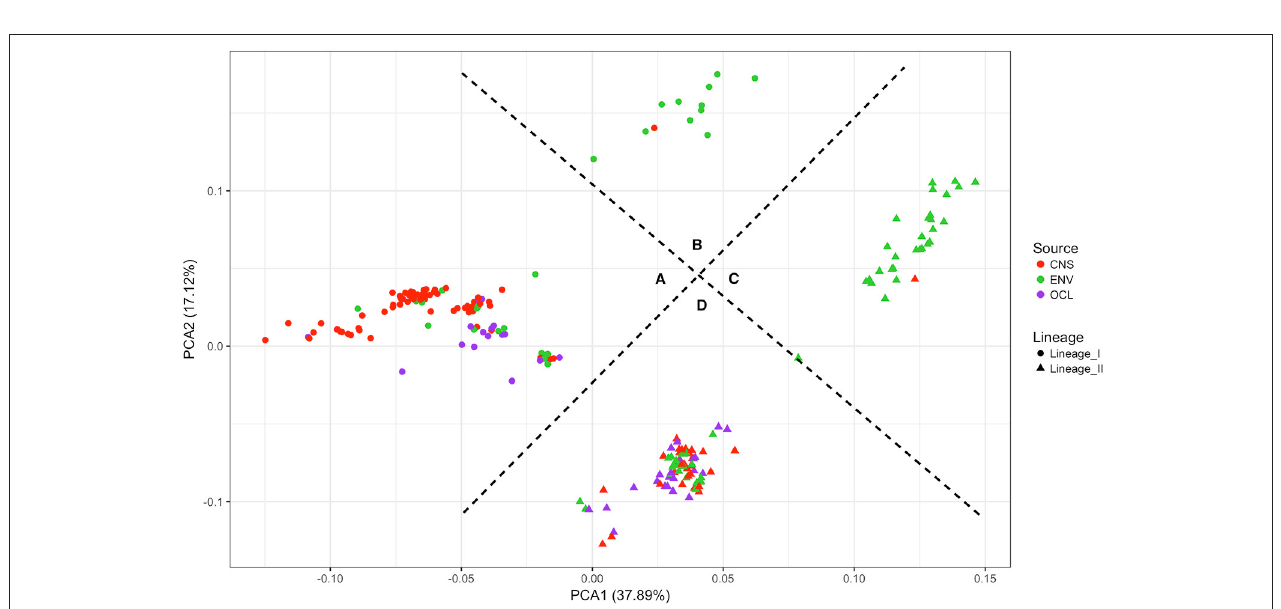
FIGURE 6 | Principal component analysis of the RPKM matrix. Four groups are defined based on the clustering. (A) lineage I clinical, (B) lineage I non-clinical, (C) lineage II non-clinical and (D) lineage II clinical.